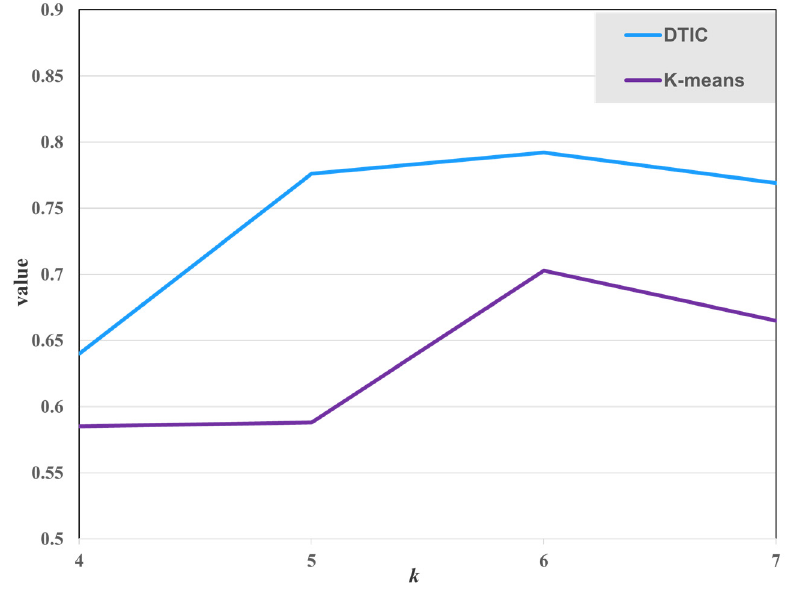
Figure 15. The clustering performance for various choices of 𝑘 with random initial cluster centers on the Reunion Island Dataset.